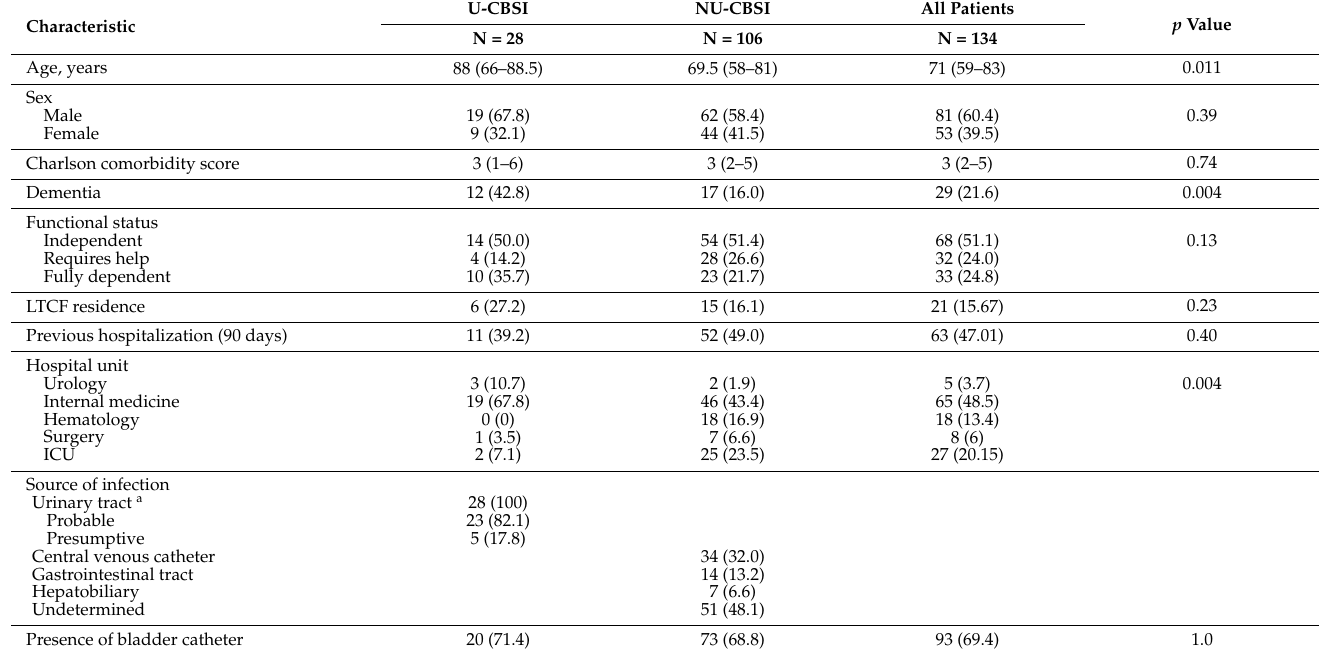
Table 1. Characteristics of patients with Candida bloodstream infection of urinary and non-urinary origin.